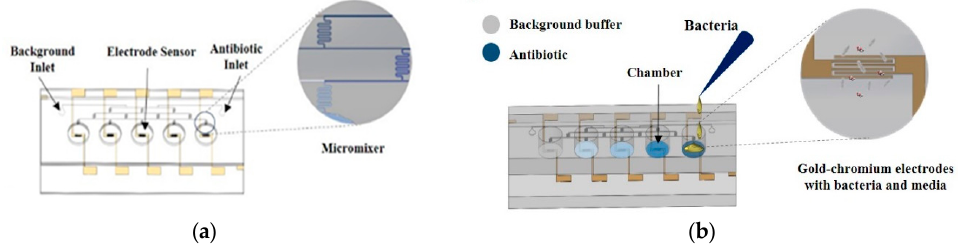
Figure 7. Schematic representation of the proposed electrochemical microfluidic chip showing ( a ) inlet, electrodes and micromixer and ( b ) bacterial and antibiotic loading in the micro well.